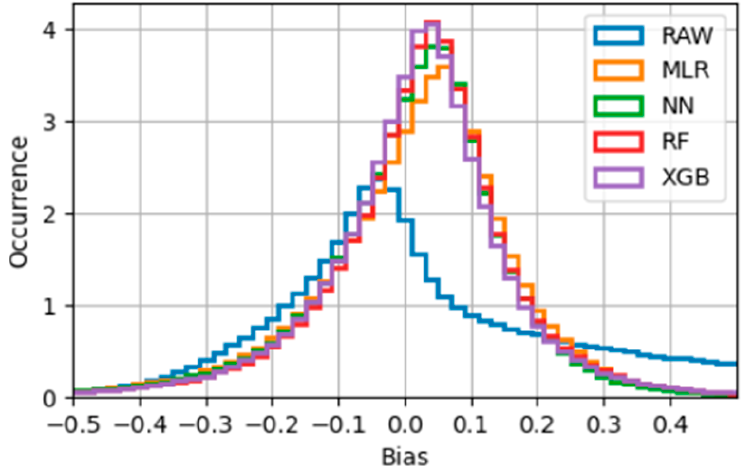
Figure 8. Histogram showing the frequency per 0.02 bin size bias, which is the difference between modeled (raw CHIMERE) or corrected (ML models) AOD 550 and satellite observed AOD 550 from MODIS for D Test .